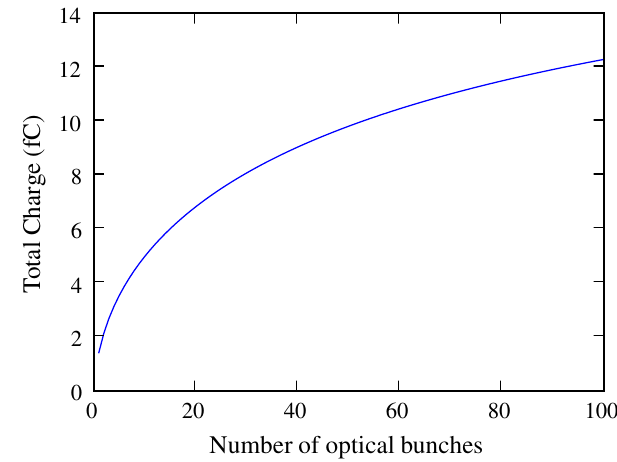
FIG. 6. The optimum total charge of a bunch train or maxi- mum efficiency as a function of the number of optical micro- bunches.